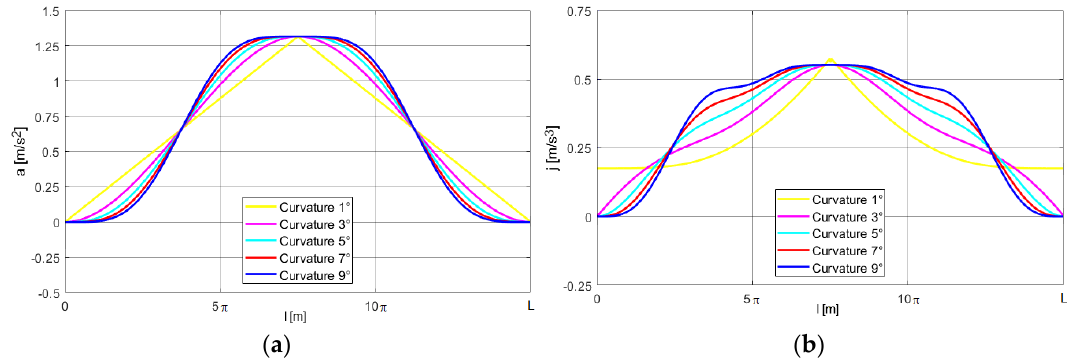
Figure 9. The course of the resultant kinematic quantities for the HoC trajectory: ( a ) acceleration; ( b ) jerk. ( b ) jerk. Agriculture 2020 , 10 , x FOR PEER REVIEW